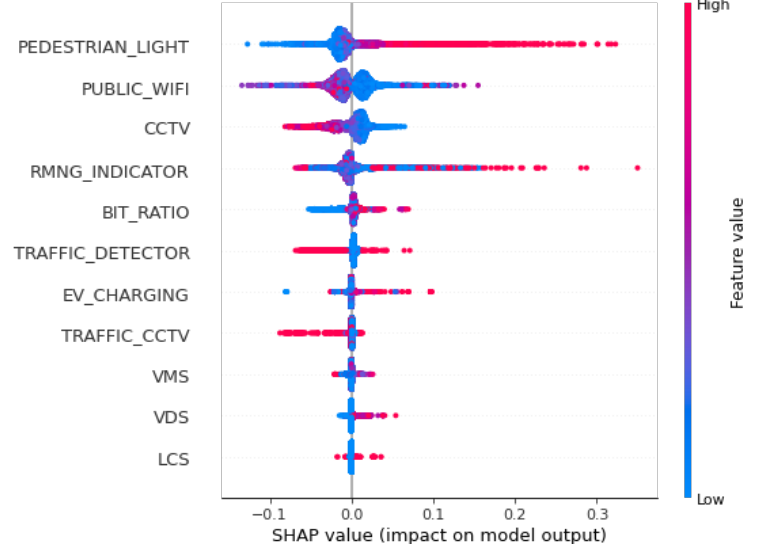
Figure 13. A summary plot for smart transportation-related features.